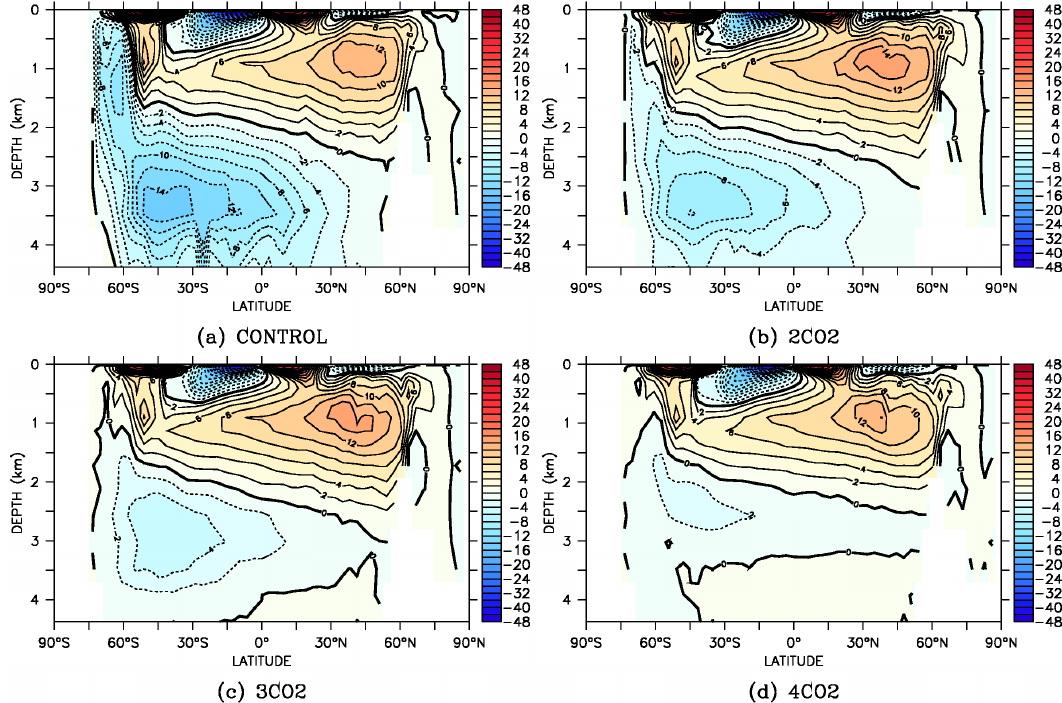
Fig. 25. The average global meridional overturning streamfunction (Sv) for years 3901–4000 of each experiment: (a) CONTROL, (b) 2CO2, (c) 3CO2, and (d)